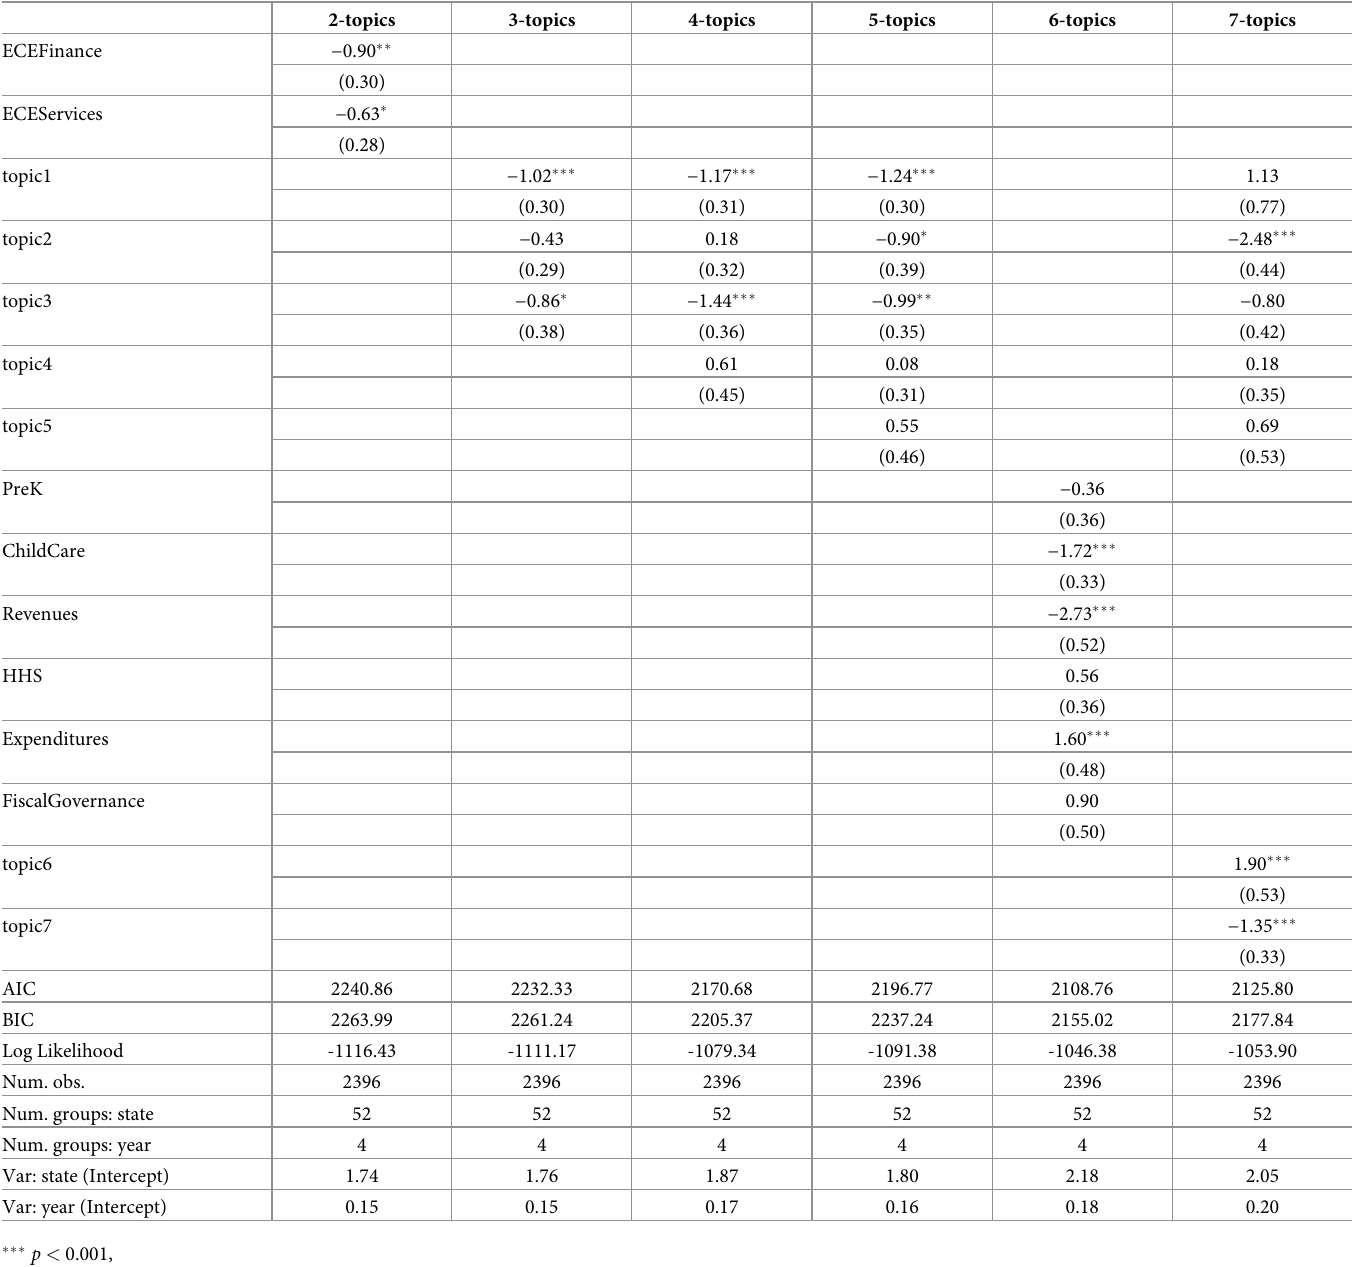
Table 3. Models predicting bill passage using LDA for topic classification with different numbers of